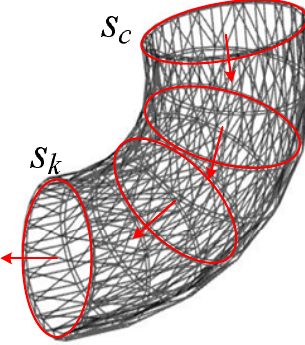
Figure 4. An example of MEP elements.